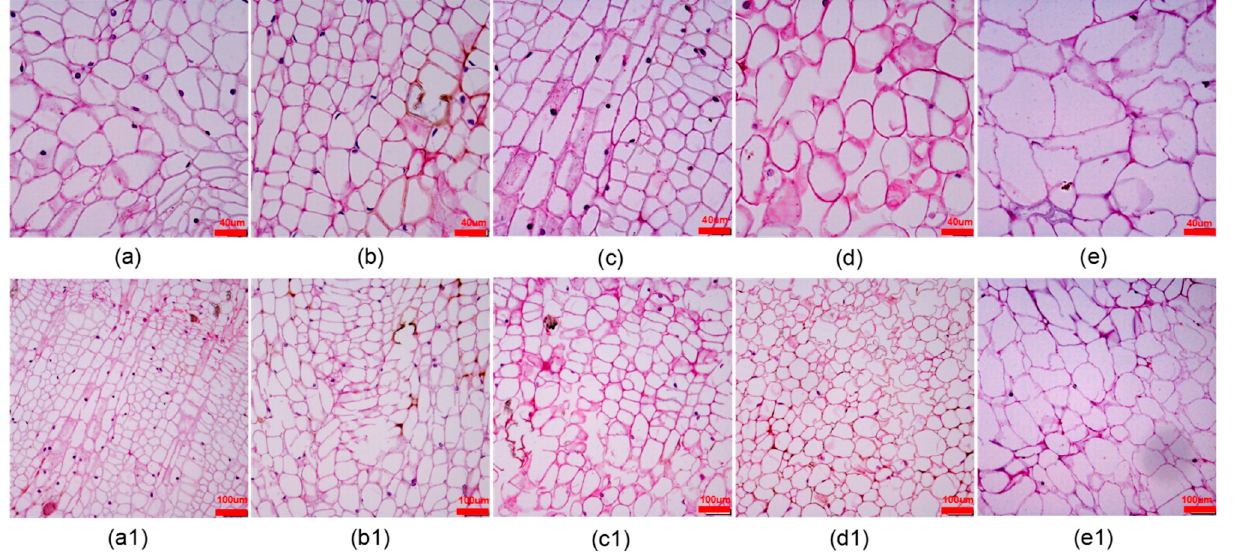
Figure 5. Callus cell morphology after repeated subcultures of callus of D. lotus . Generations 1–5 are shown in columns a–e (a1–e1), respectively.